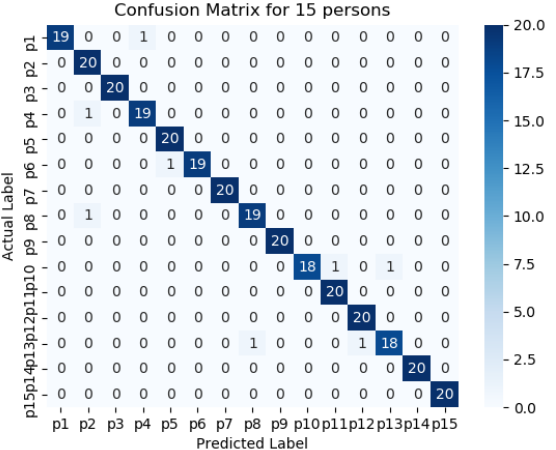
Figure 12. Confusion matrix of the proposed model for the ten persons.